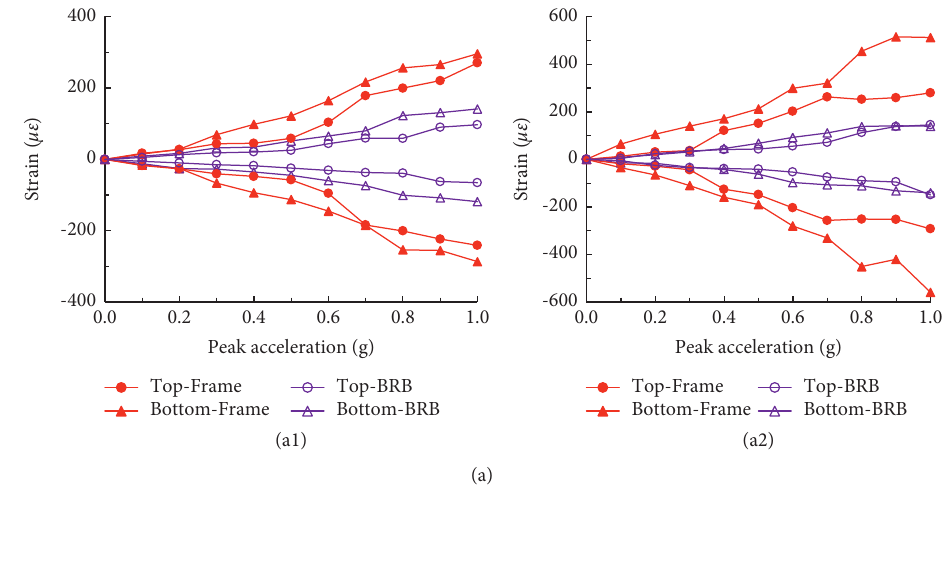
Figure 18: Time-history curves of stain at the end of beam. (a) El Centro wave. (b) Kobe wave. (c) Taft wave.